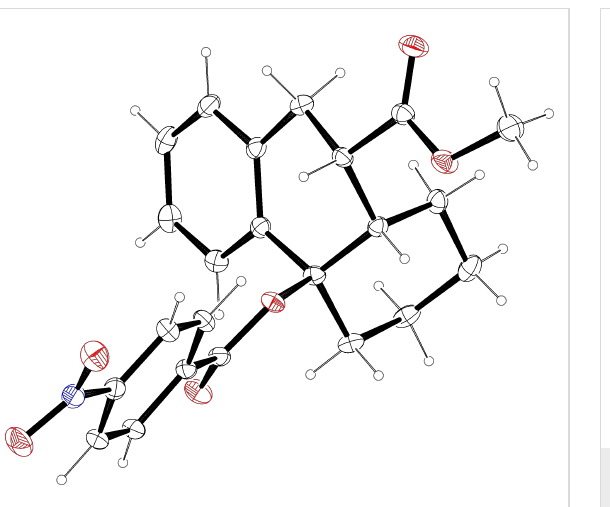
Figure 2: Molecular structure (ORTEP, [14]) of compound 14a (ther- mal ellipsoids at 50% probability).